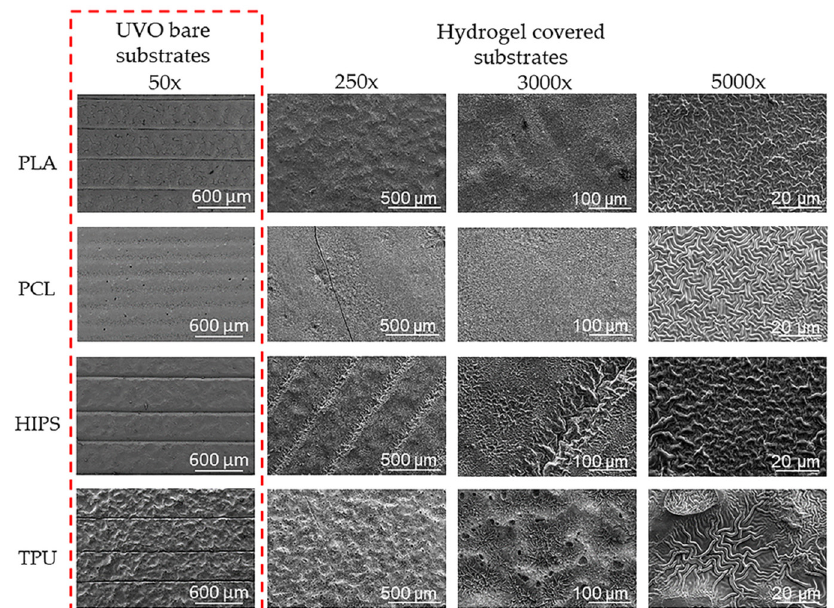
Figure 4. FE-SEM micrographies of the wrinkle patterns in different substrates using magnifications of 250×, 3000×, and 5000×.